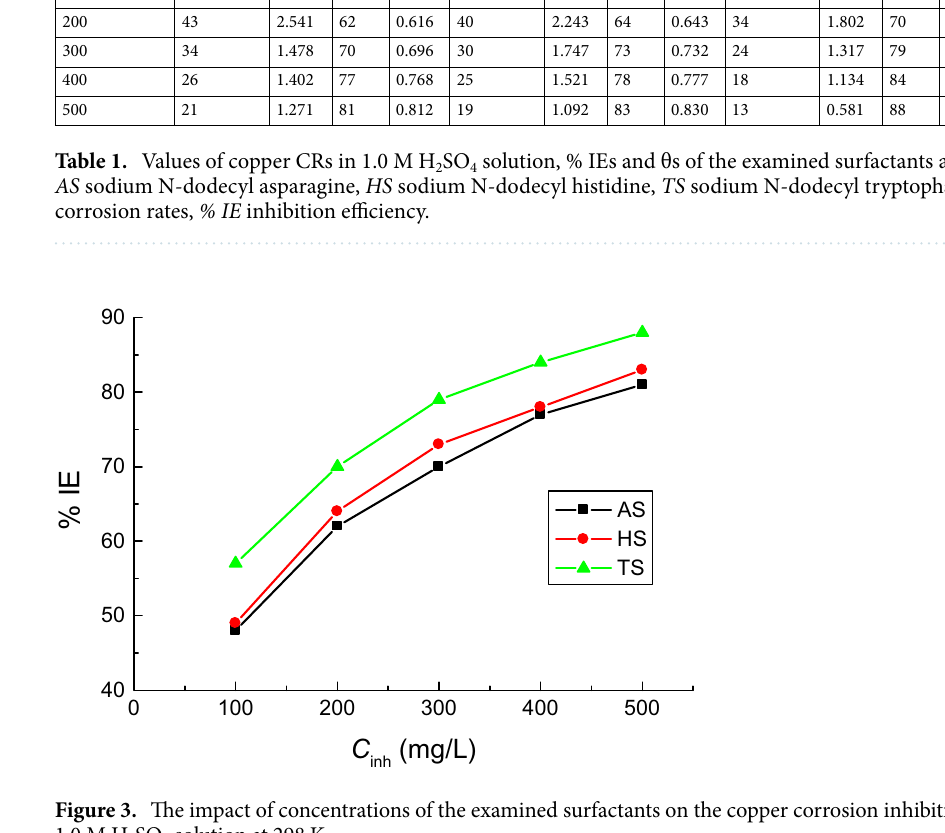
Figure 3. The impact of concentrations of the examined surfactants on the copper corrosion inhibition in 1.0 M H 2 SO 4 solution at 298